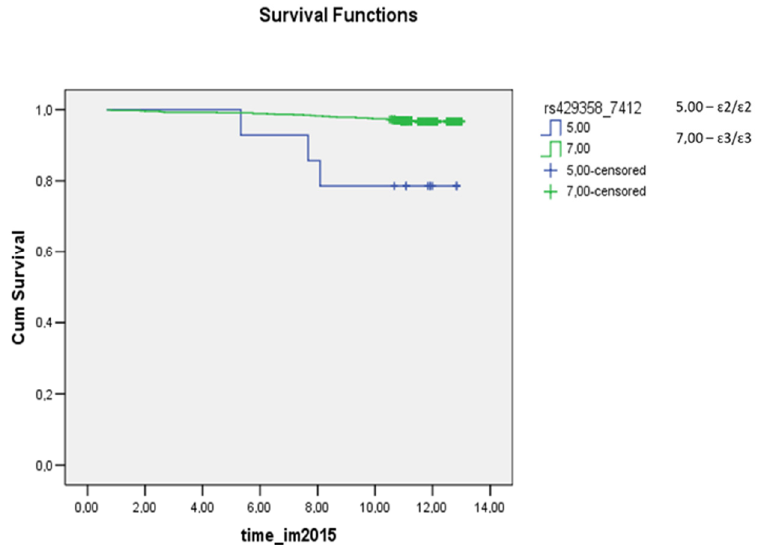
Figure 2. The survival plot for myocardial infarction in the female subgroup. The prognosis was worse for ε 2/ ε 2 carriers (blue curve) versus the widespread ε 3/ ε 3 genotype (green curve) ( p < 0.0001). time_im2015: this is the time (in years) from the start of the observation (December 2002) to the end of the study (the occurrence of myocardial infarction or the end of the observation period: December 2015). Cum Survival: the probability that the case has no outcome until the time point that we choose along the horizontal axis.